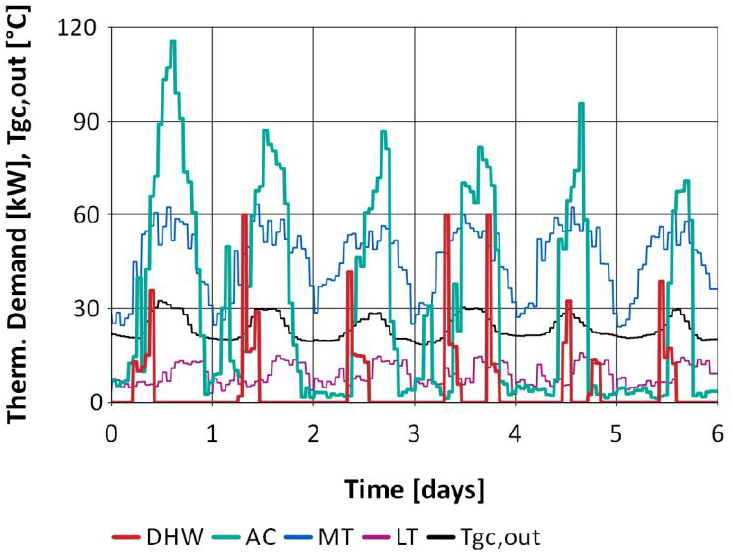
Figure 3. Measured values for thermal demands and system pressure for the integrated CO 2 refrigeration system in Porto de Mos during the evaluated week in summer 2019.